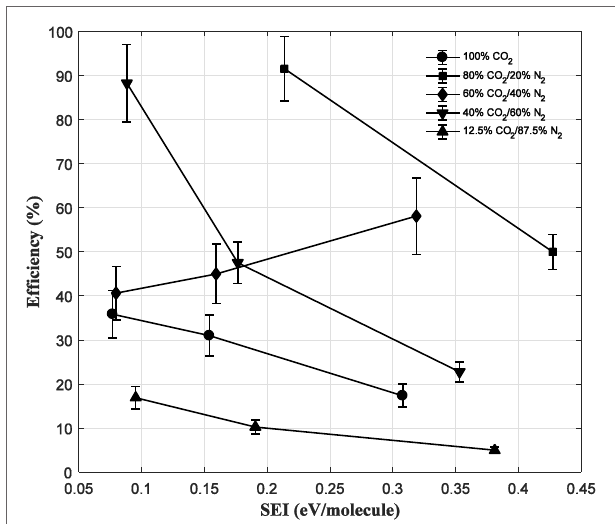
FigUre 13 | Energy efficiency as a function of specific energy input for different gas mixtures (1 eV/molecule = ca. 3.933 J/cm 3 under standard temperature and